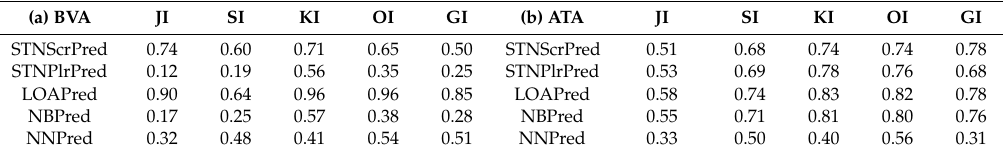
Table 5. Map similarity rates for ( a ) BVA and ( b )